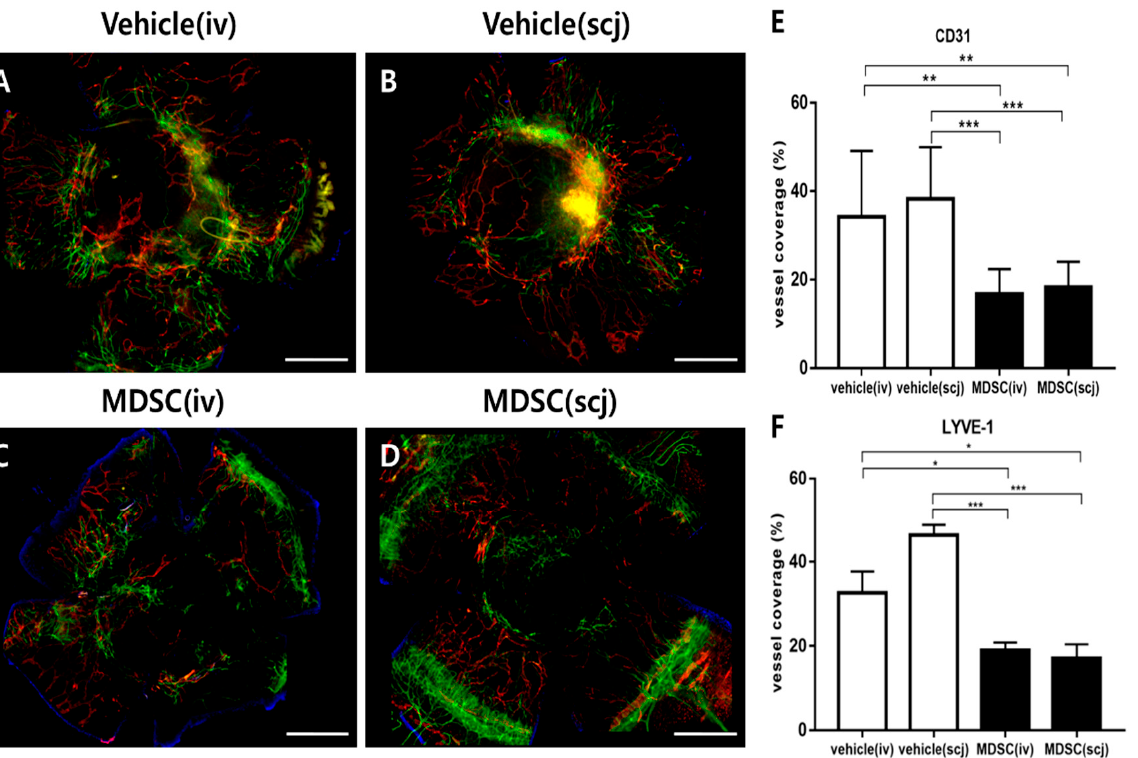
Figure 5. Comparisons of neovascularization and lymphangiogenesis in corneal allografts via MDSC administration. Representative whole-mount corneal immunofluorescent CD31 hi (green) and LYVE-1 hi (red) staining images from each group: PBSiv ( A ), MDSCiv ( C ), PBSscj ( B ), and MDSCscj ( D ). The representative photograph is a combination of multiple stitched photographs (5 × magnification, scale bar = 500 µ m) taken after dividing the whole cornea into several parts. MDSC groups (MDSCiv, MDSCscj) presented the significantly suppressed areas of neovascularization ( E ), green-CD31 hi ; white arrows for blood vessels) and lymphangiogenesis (( F ), red-LYVE-1 hi ) rather than those of the vehicle groups (PBSiv, PBSscj). Data are presented as the mean ± SEM of three repeated experiments involving three corneas per group ( E , F ); * p < 0.05, ** p < 0.01, and *** p < 0.001)).